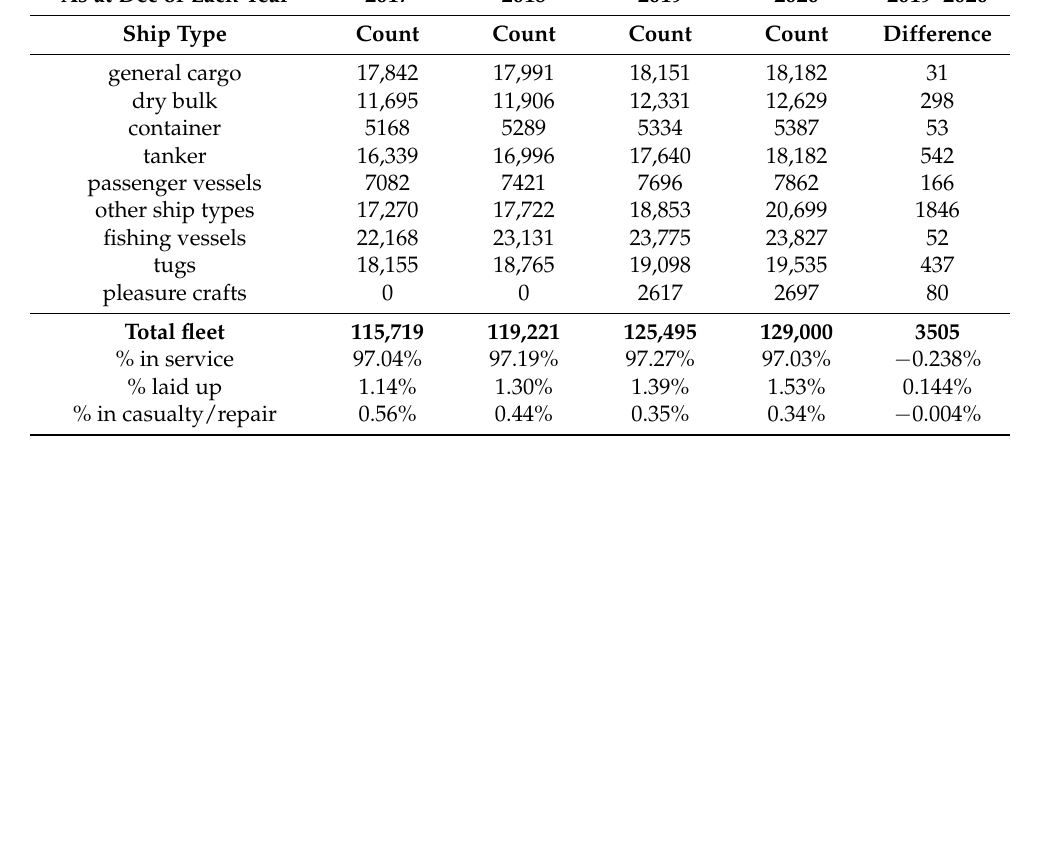
Table A1. Counts by ship type and vessel status, as % to total fleet (2017 to 2019). As at Dec of Each